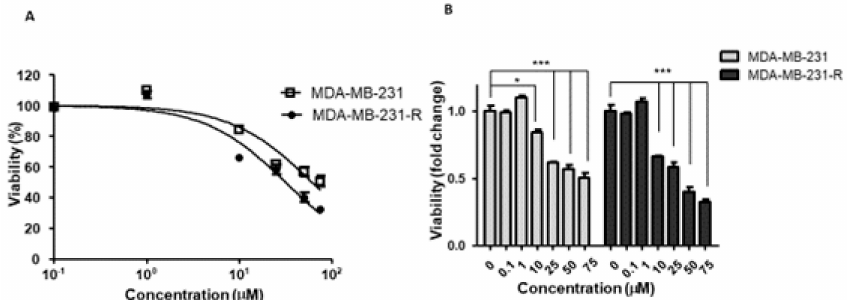
Figure 5. Increased sensitivity of MDA-MB-231-R cells to FGFR1 signaling blockade. Cells in complete medium were treated for 72 h with the FGFR1 inhibitor PD166866 and cell proliferation measured by the MTT assay. Shown in ( A ) is a dose response curve and in ( B ) a bar graph depicting the anti-proliferative effect of PD166866. Results are expressed as means ± SE ( n = 3) relative to the respective, vehicle-treated controls that were assigned a value of 100% and 1, respectively. * p < 0.05, *** p <